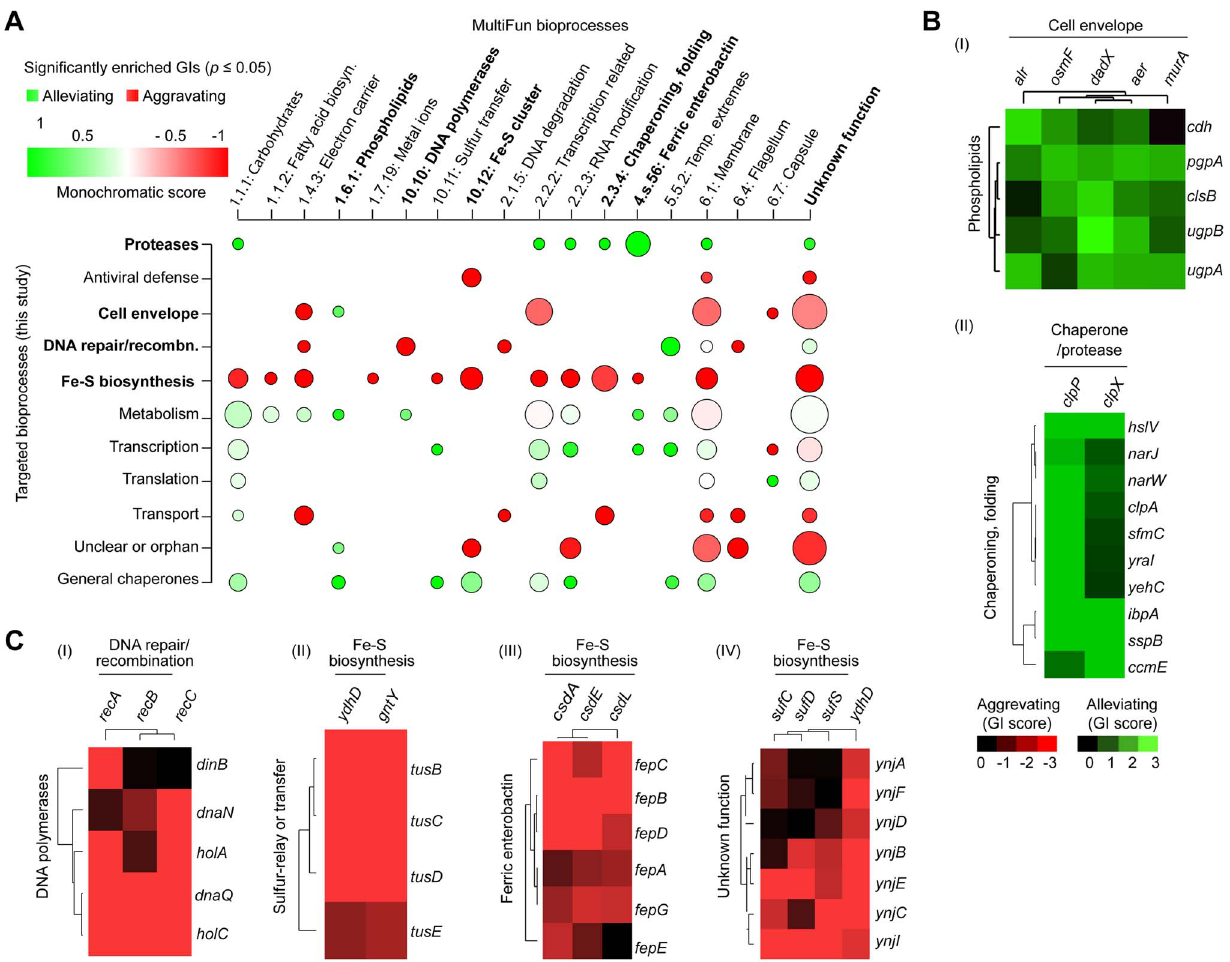
Figure 3. Monochromaticity of GIs among bacterial bioprocesses. (A) Heatmap displaying the distribution of significantly enriched ( p -value # 0.05) aggravating or alleviating GIs between functional categories. Node size represents the number of enriched GIs per process, while the color indicates the monochromaticity type: red for aggravating (monochromatic score of 2 1) and green for alleviating (monochromatic score of + 1). Only representative MultiFun processes (x-axis) are shown. Highlighted (bold) crosstalk processes are shown as separate sub-networks in panels B and C. Heatmaps showing overlapping patterns of alleviating (B) or aggravating (C) GIs for representative genes within particular categories after hierarchical